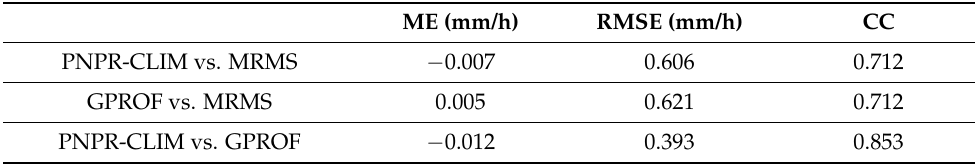
Figure 5. HSS ( left panel ), POD ( right panel ) and FAR ( bottom pane l) achieved by PNPR-CLIM (blue dots) and GPROF (red dots) against MRMS for different detection thresholds. The Precipitation/No-precipitation convention is specified in the text. Table 5. ME, RMSE and CC between PNPR-CLIM, GPROF and MRMS using the entire